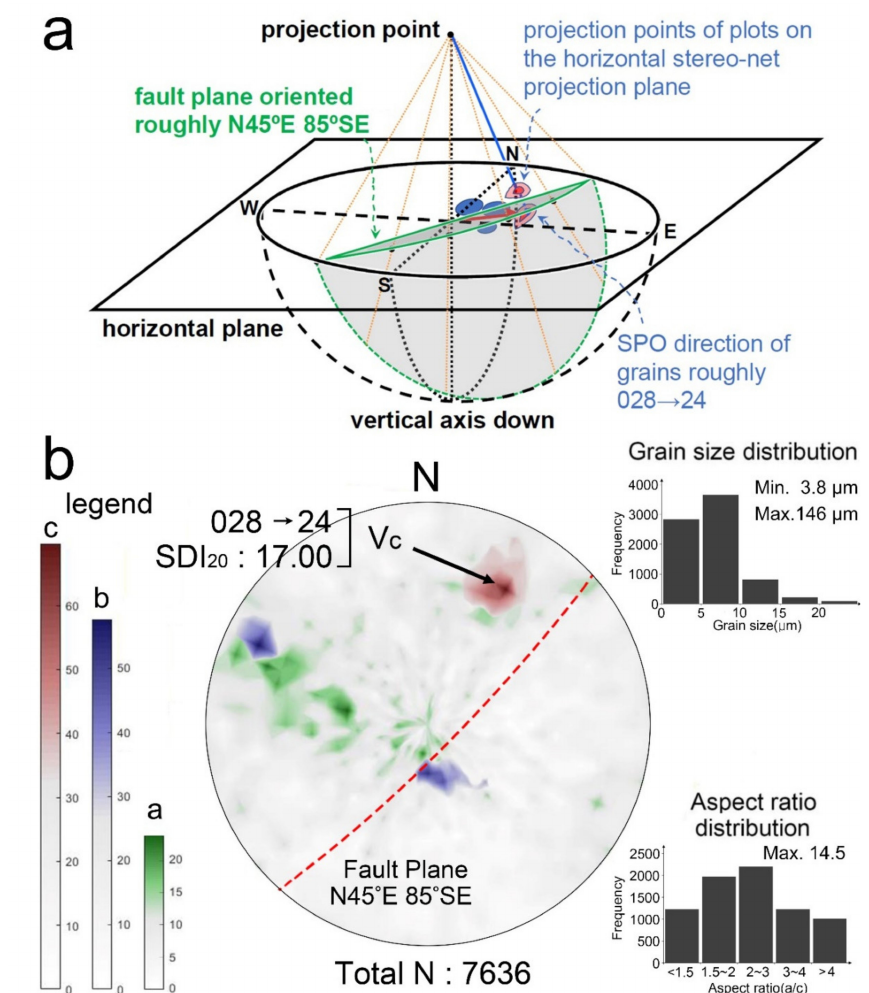
Figure 6. ( a ) The diagram shows the relationship between the fault plane and the SPO of grains plotted on stereo-net. The fault motion sense depends on the relative position of the SPO to the fault plane. ( b ) SPO measurement results for the BK-1 sample. Each SPO data of major, middle, and minor axis are shown as red, blue, and green, respectively. For fault plane N45 ◦ E 85 ◦ SE, the densest point of SPO of major axis is directed from 028 → 24. Most of the grains examined had a size of less than 15 µ